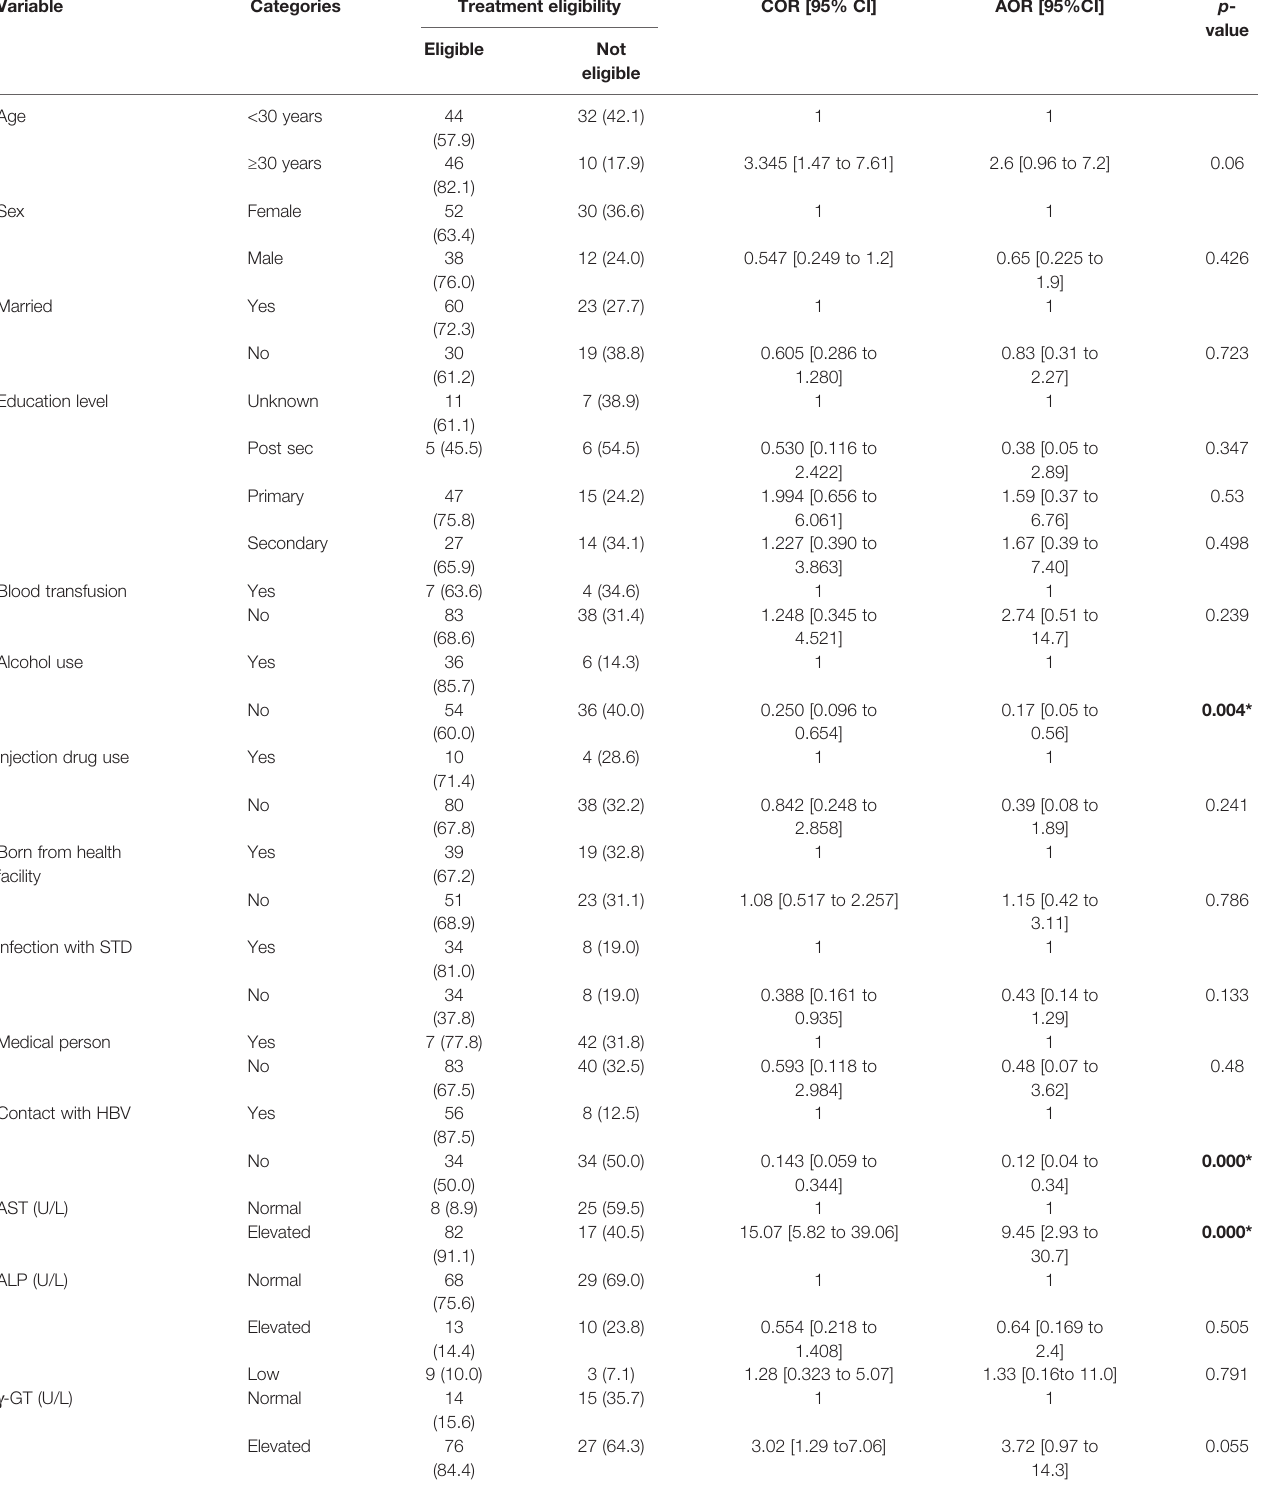
TABLE 3 | Socio-demographic factors and liver function tests associated with treatment eligibility among the HBsAg seropositive participants from the low endemic region.